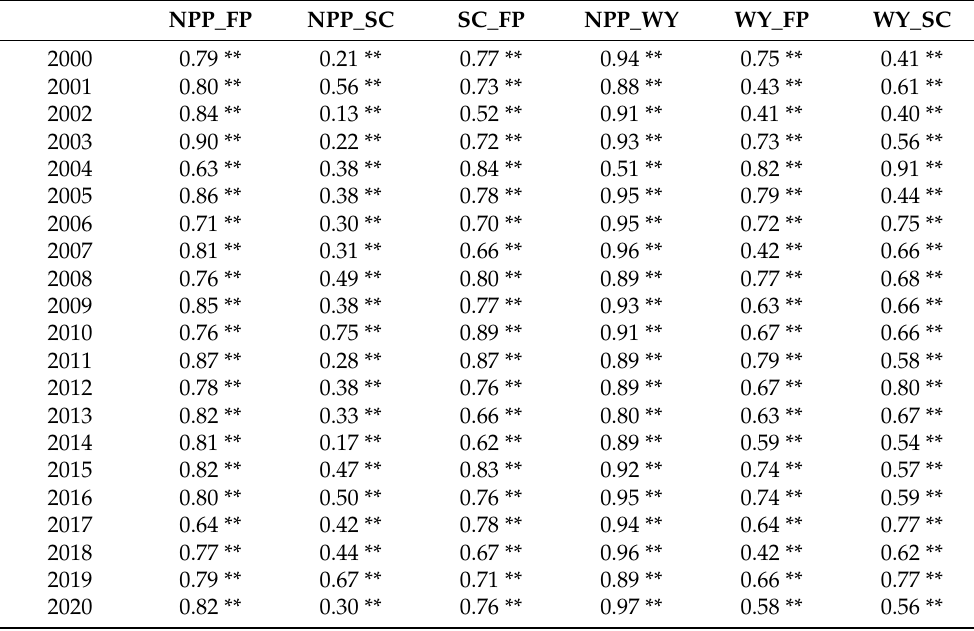
Table 3. The goodness of fit values (R 2 ) of the constraint